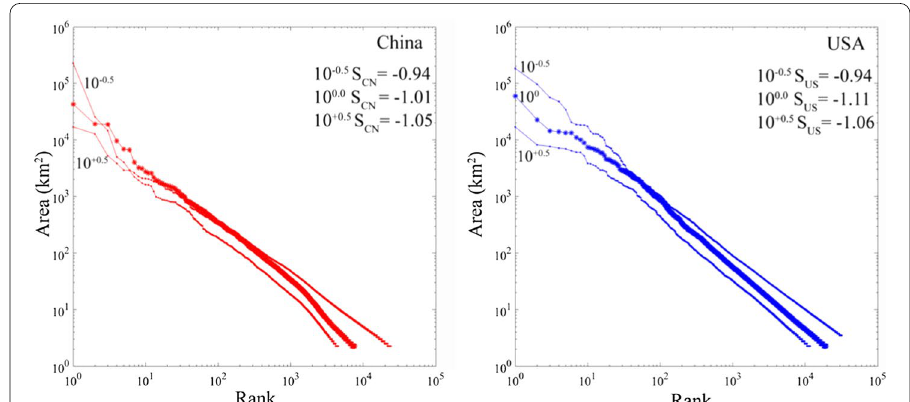
Fig. 7 Varying spatial connectivity affects network size, with little effect on scaling (slope). Increasing the low luminance threshold reduces the size, number and connectivity of components, but does not change the slope of the rank-size distributions. For China, the lower threshold results in the interconnection of several large components to form a single very large component on the Changjiang delta and Yangtze River basin— thereby disrupting the scaling of the upper tail. A similar effect is seen in ranks 30 to 100 for the